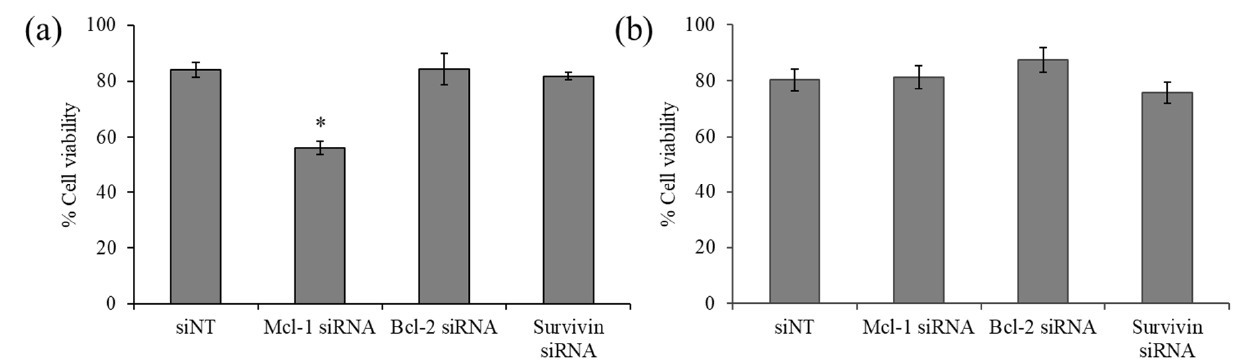
Figure 4. Cell viability of indicated siRNA targeting (Mcl-1, Bcl-2, and survivin) using delivery of PCN-B in ( a ) MCF-7 and ( b ) MDA-MB-231 cells. * p < 0.05.